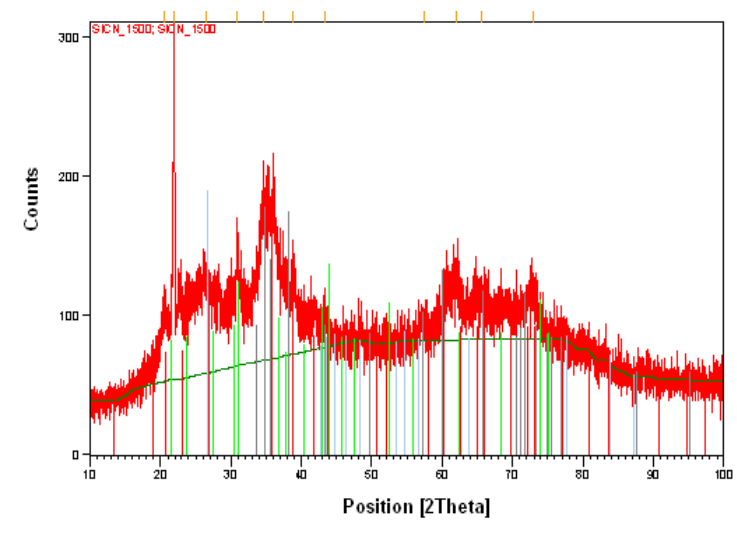
Figure 13 b. Peak list for SICN annealed to a temperature of 1,500